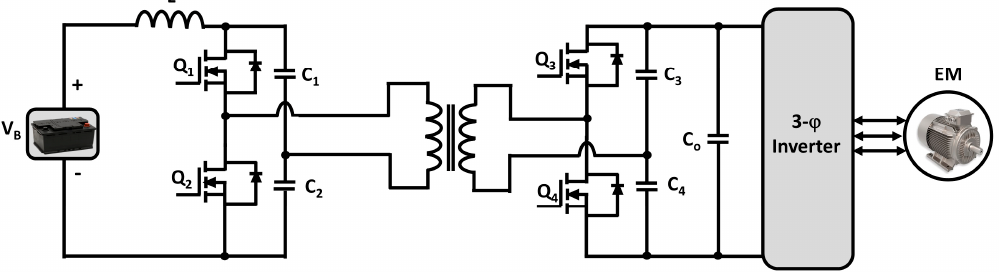
Figure 26. Isolated Zero Voltage Switching (ZVS) DC–DC Converter.